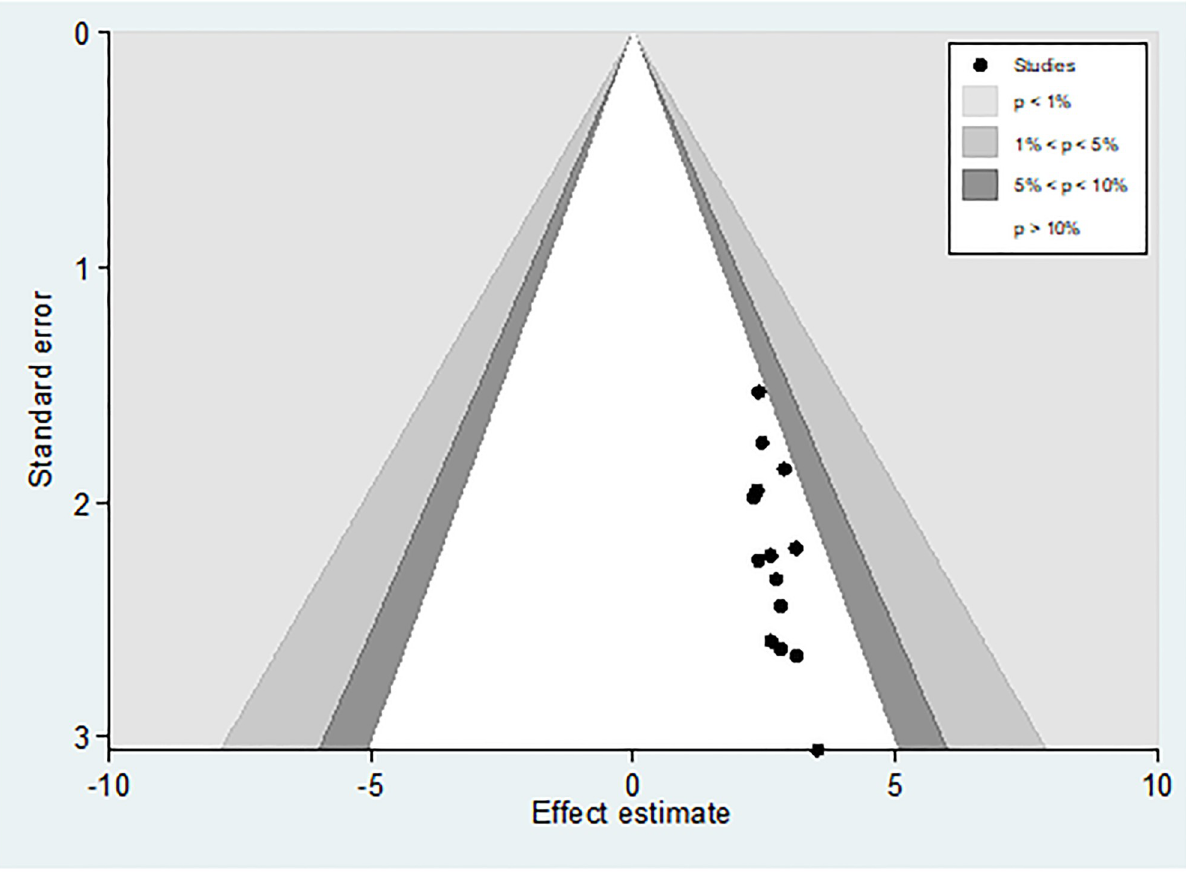
Fig 6. The trim-and-fill method was used to correct the result of one potentially missing study was required in the right side of the funnel plot to ensure symmetry.